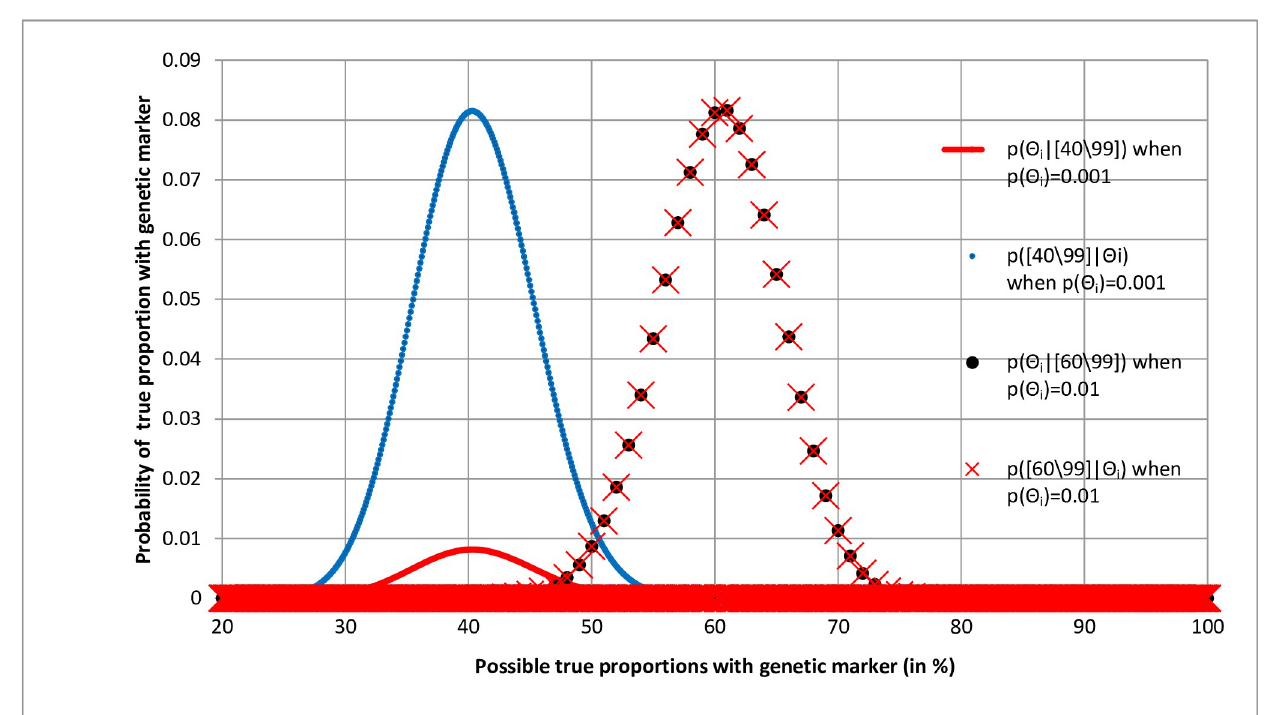
Fig 2. Comparing effects of prior probabilities of 0.01 and 0.001 for true proportions on the likelihood and posterior distributions of observed proportions of [40\99] and [60\99].